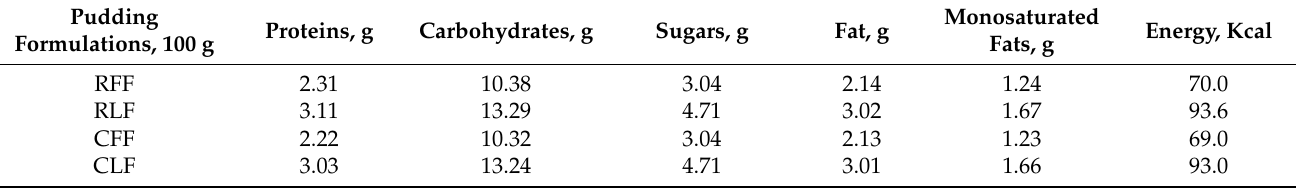
Table 3. Nutritional data of pudding formulations (RFF—rice starch, peach pur é e; RLF—rice starch, lyophilized